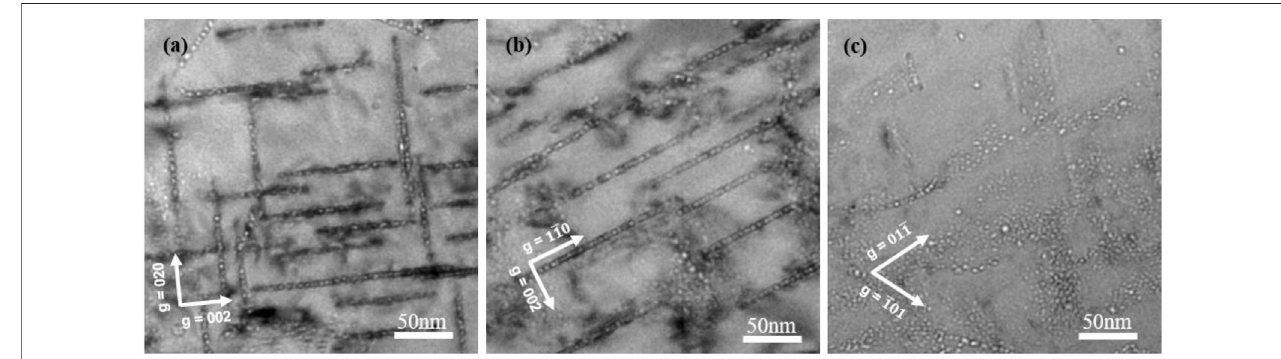
FIGURE 5 | TEM BF images showing the structure of bubble-loop complexes: (A) under < 100 > zone axis, (B) under < 110 > zone axis, and (C) under < 111 > zone axis.